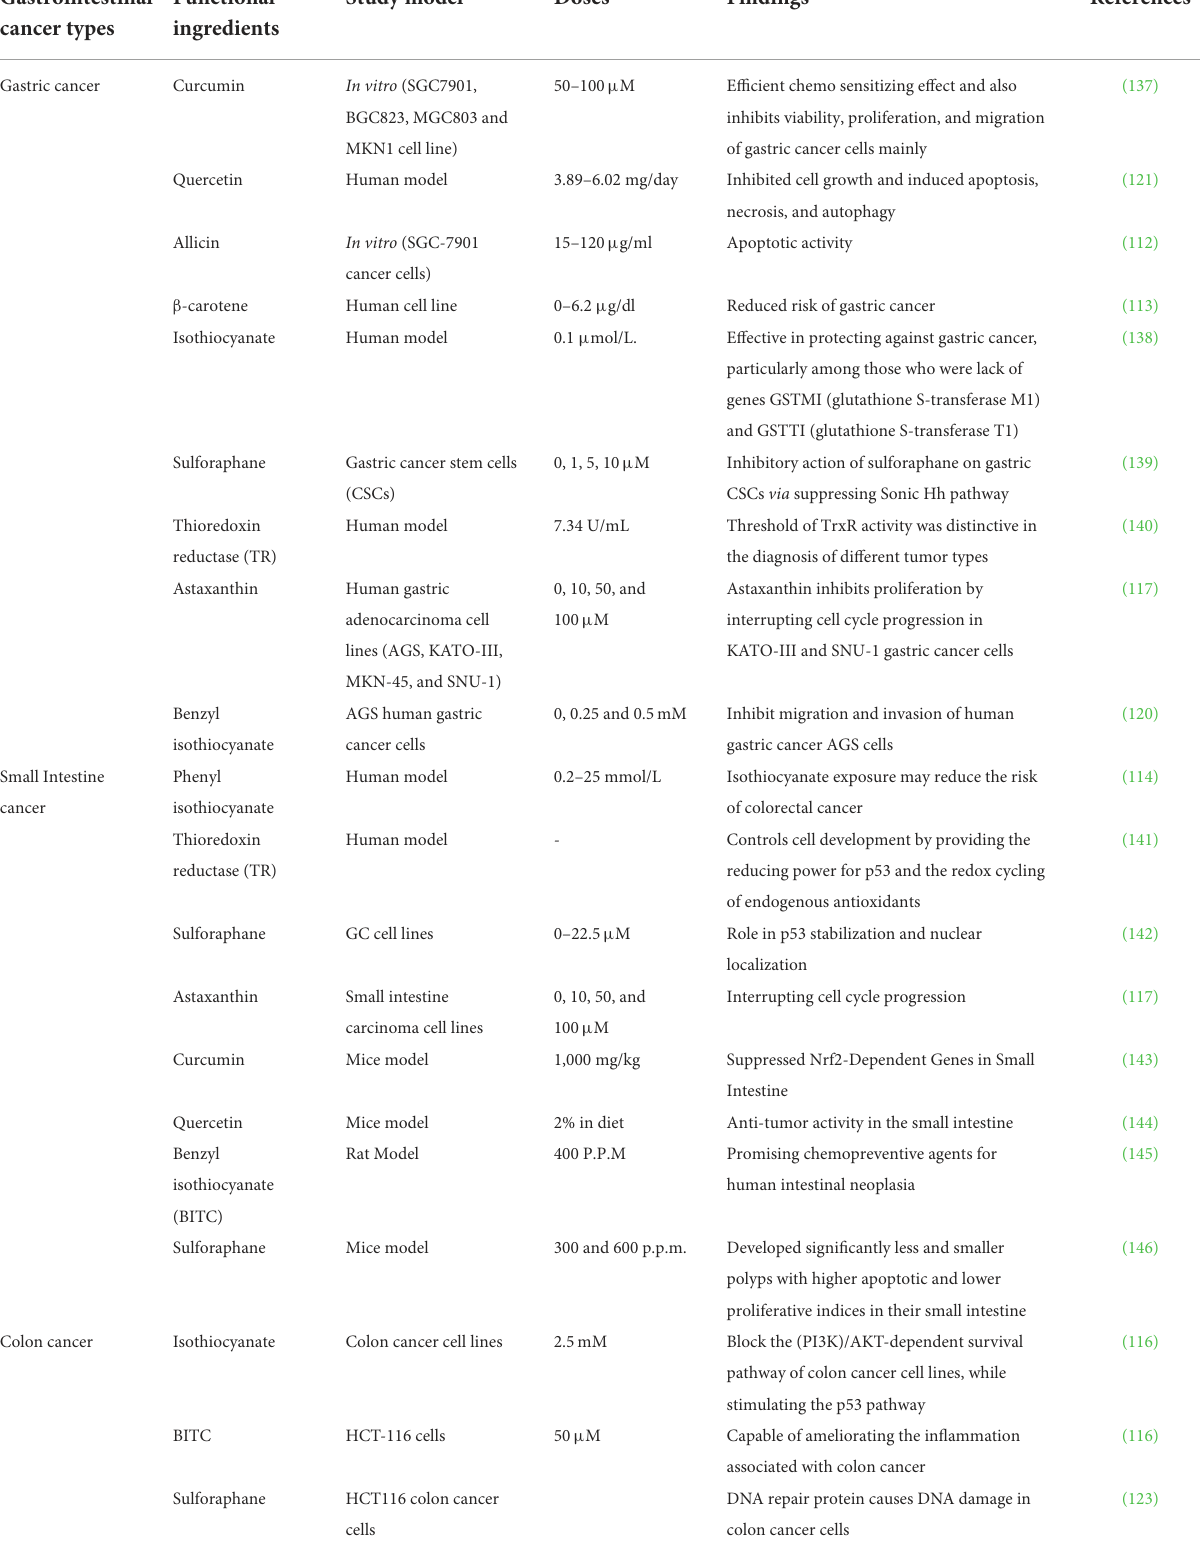
TABLE 4 Functional ingredients from cruciferous vegetables in gastrointestinal tract and associated